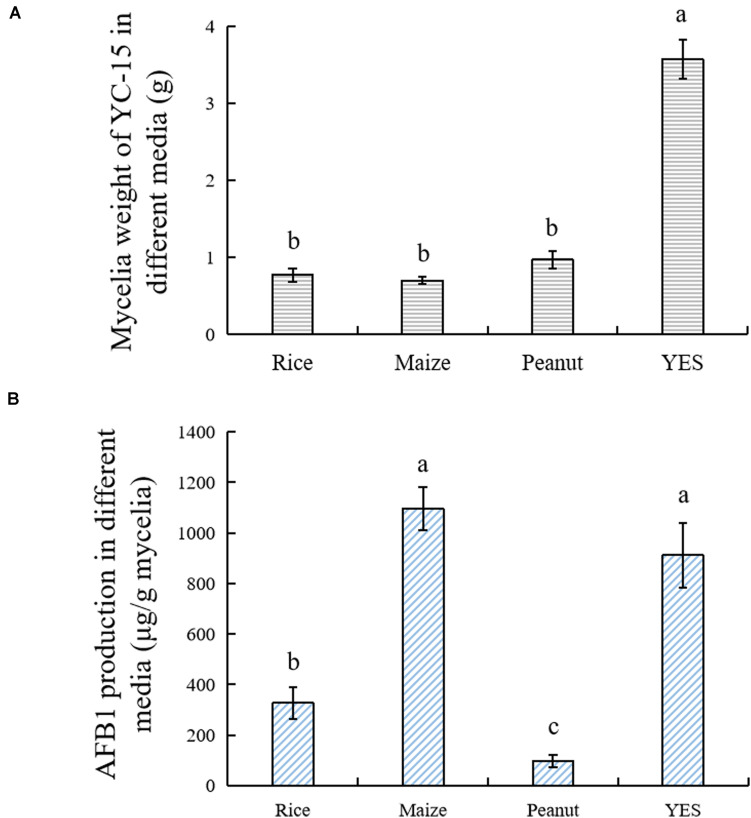
The growth and AFB1 production of A. flavus YC-15 in different media. The strain was cultivated in four different media with 200 rpm at 28°C. The (A) mycelia dry weight and the (B) AFB1 production were measured after 7 days cultivation. All experiments were performed in three independent replicates. The results were presented as mean ± SD, and error bar indicated SD. The Tukey’s test was used for difference analyses and p < 0.05 was considered as statistical difference.